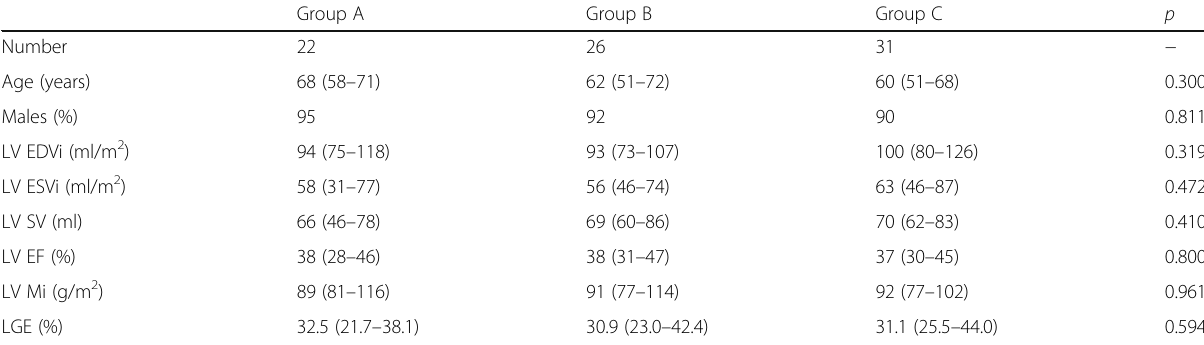
Table 1 Demographics, left ventricular function and volume, and scar data from the three study subgroups Group A